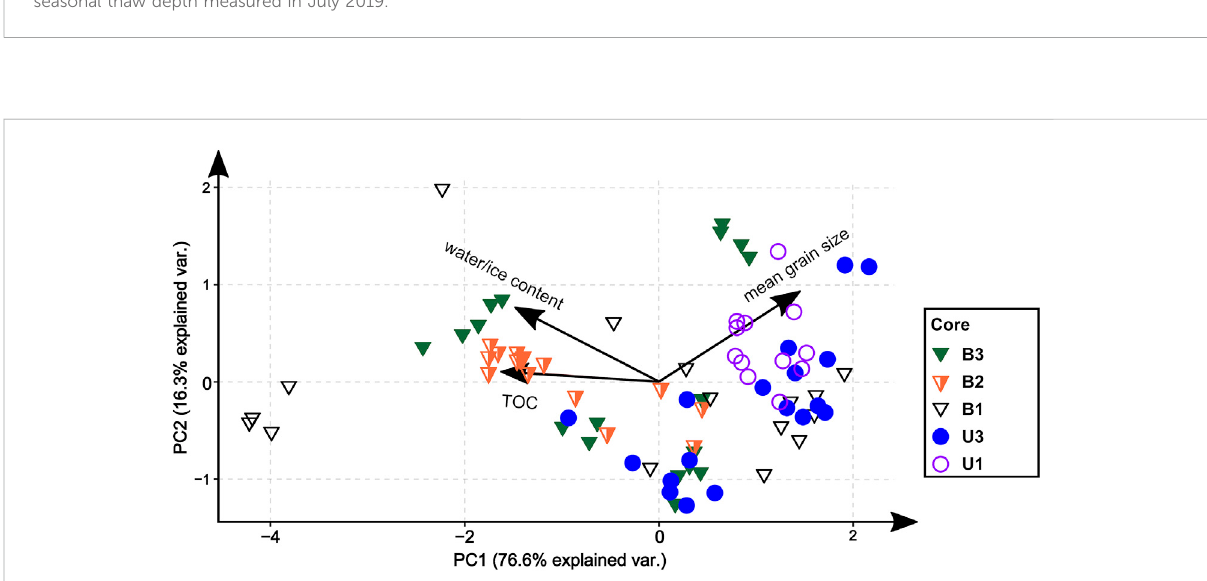
FIGURE 6 Grain size distribution for all sampling sites plotted against depth; absolute water and/or ice content added in blue; dashed lines mark the seasonal thaw depth measured in July 2019.